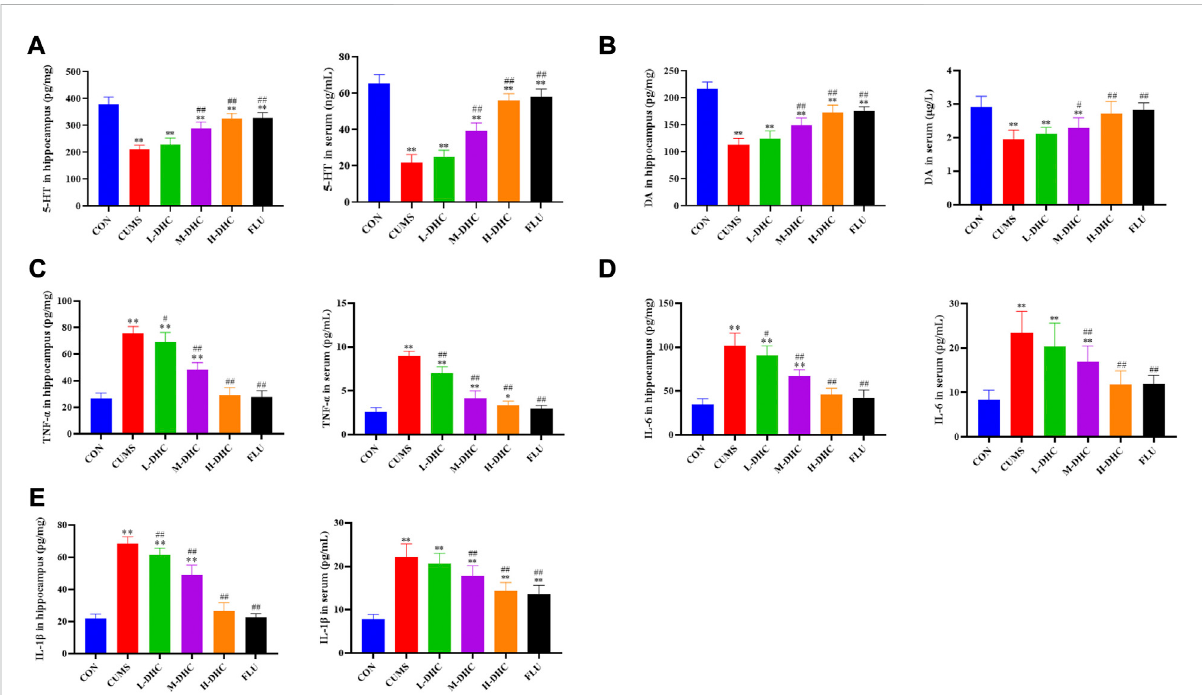
FIGURE 4 Effects of DHC or fl uoxetine on 5-HT, DA, and proin fl ammatory factor levels in CUMS-induced depression in mice. (A) 5-HT level was determined in serum and hippocampus, (B) DA level was determined in serum and hippocampus, (C) TNF- α level was determined in serum and hippocampus, (D) IL-6 level was determined in serum and hippocampus, and (E) IL-1 β level was determined in serum and hippocampus. * p < 0.05 and ** p < 0.01, compared with the control (CON) group; # p < 0.05 and ## p < 0.01, compared with the CUMS